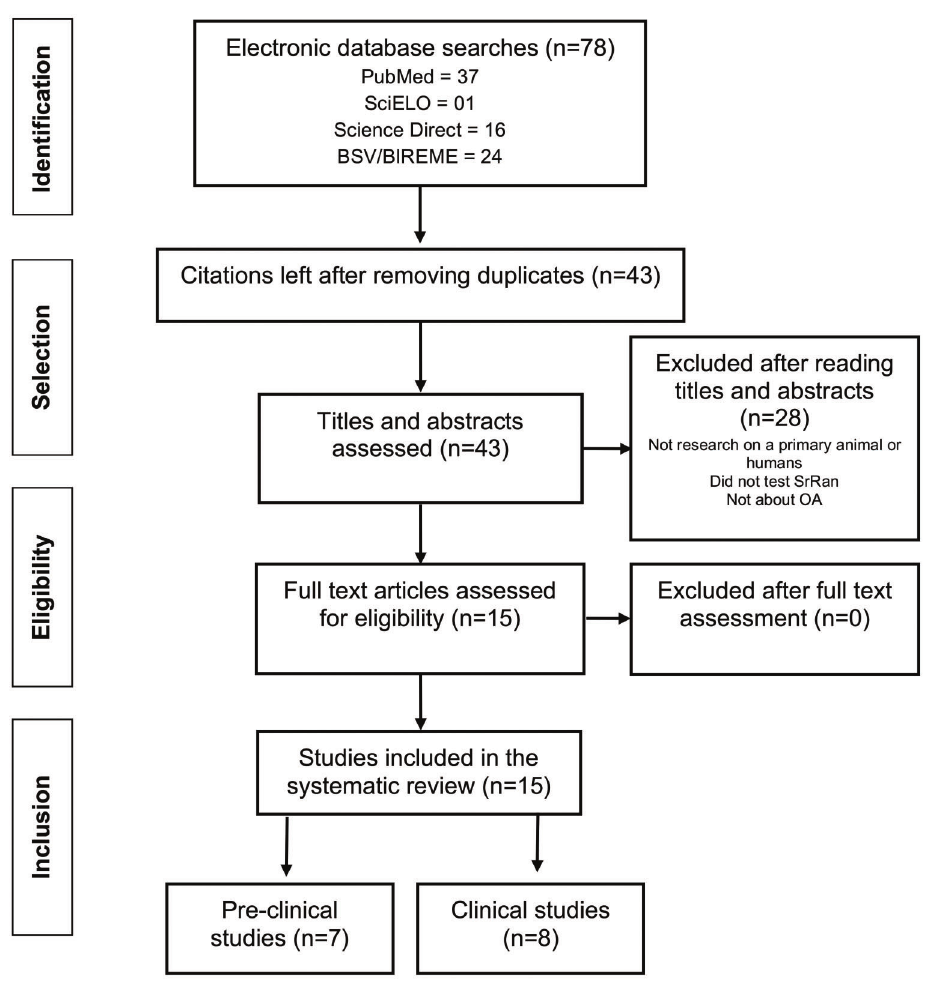
Figure 1. Flowchart of systemic review article search. OA: osteoarthritis; SrRan: strontium ranelate.